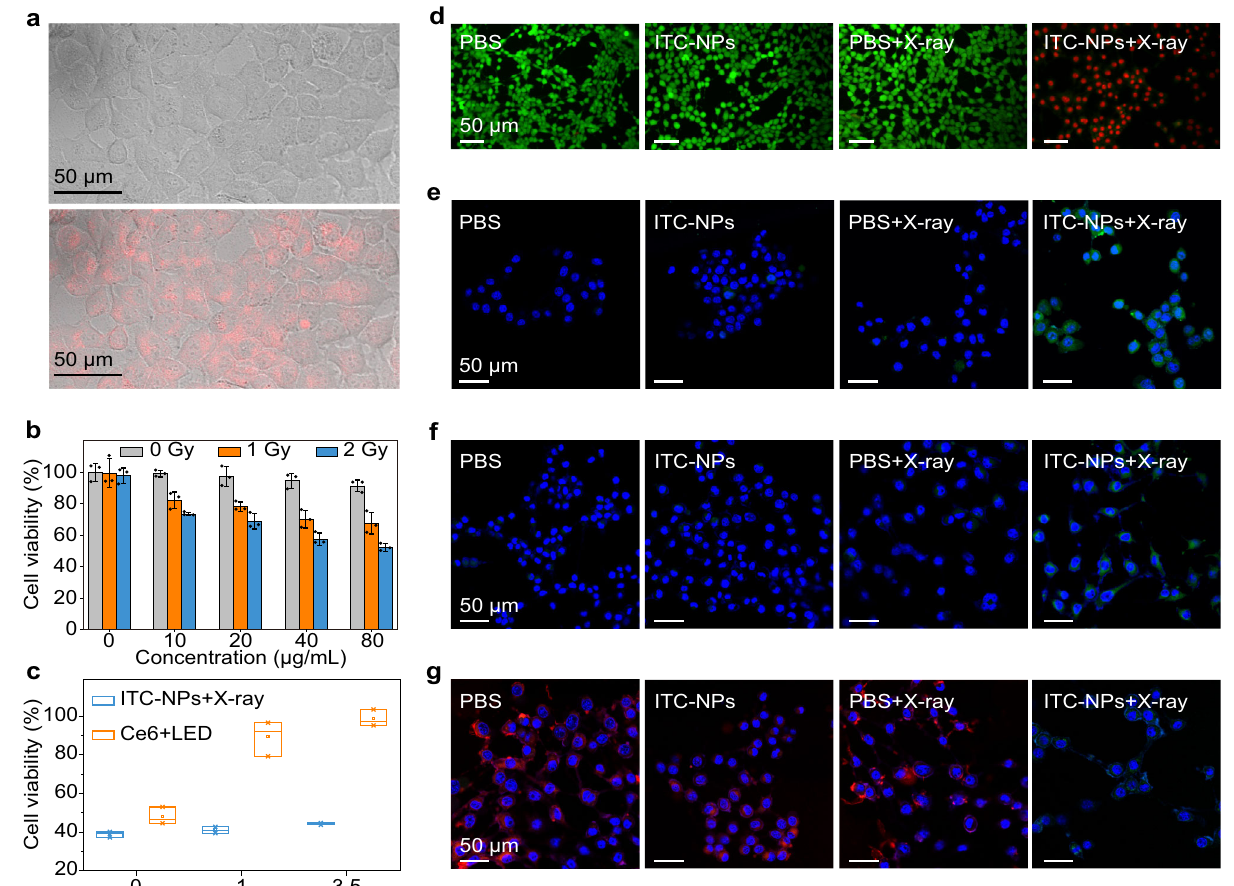
Fig. 3 | Evaluation of organic phosphorescent nanoscintillators for X-PDT in vitro. a Confocal microscopic images of 4T1 cells after incubation with ITC nanoparticles (ITC-NPs). The red colour (bottom) is from the phosphorescence of the ITC-NPs, indicating effective cell uptake, as it appears in the same position as the bright- fi eld images of the 4T1 cells (top). b Viability of 4T1 cells incubated with different concentrations of ITC-NPs. Note that each group was treated parallelly with or without X-ray irradiation (1 or 2Gy). The statistical data are expressed as mean values±S.D. ( n =3 independent experiments). Note that the total dose that medium and cells irradiated is1-2Gy. c Chicken breast blockdepth dependence of viabilityof4T1cellsincubatedwithITC-NPs(X-ray:2Gy)orCe6(LEDlight:670nm, 300mW/cm 2 , 90J/cm 2 , 300s). Median and interquartile ranges are presented